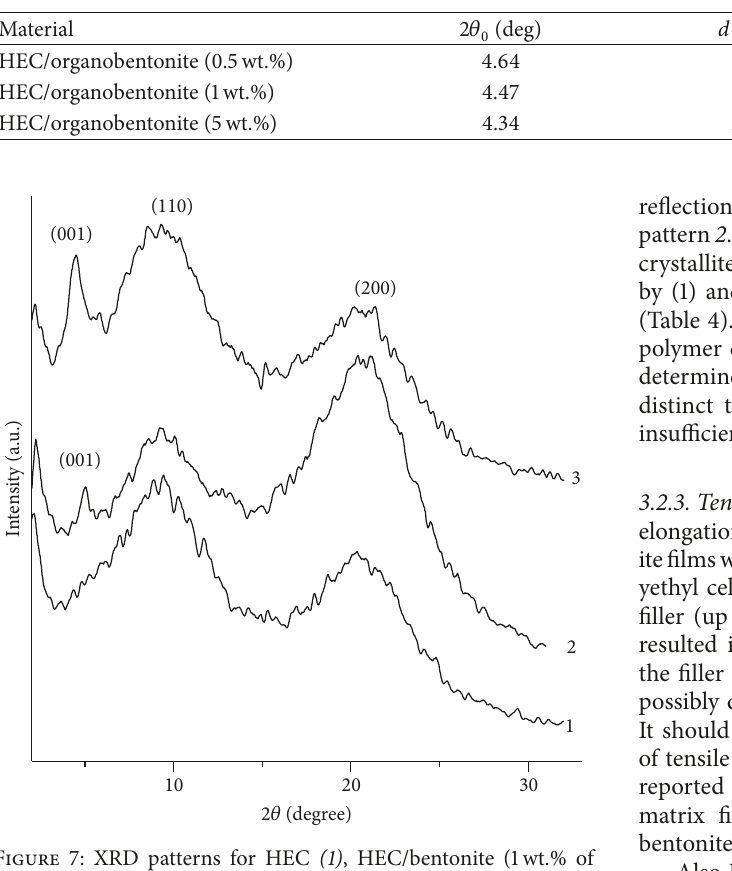
Table 4: Structural-crystal characteristics of the HEC/organobentonite composite films.